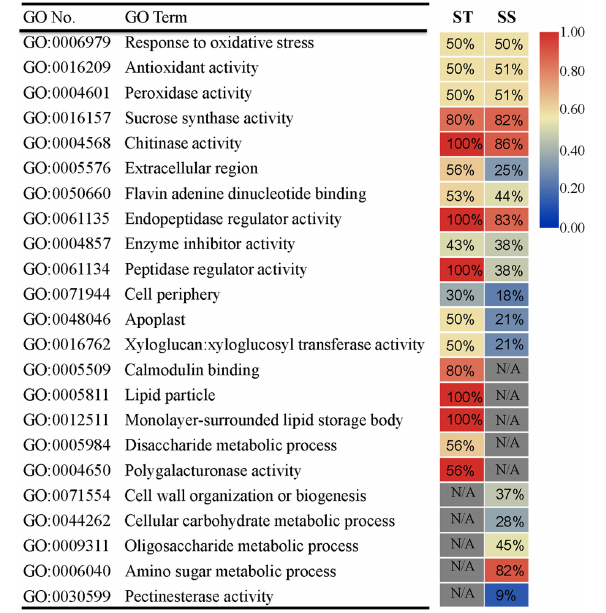
FIGURE 3 | Gene ontology (GO) enrichment analysis of DEGs (FC ≥ 2) in ST or SS. The heat map indicates the ratio of upregulated genes for each GO term. N/A indicates absence of DEGs in enriched GO terms. Only the top 18 most enriched GO categories of each genotype are